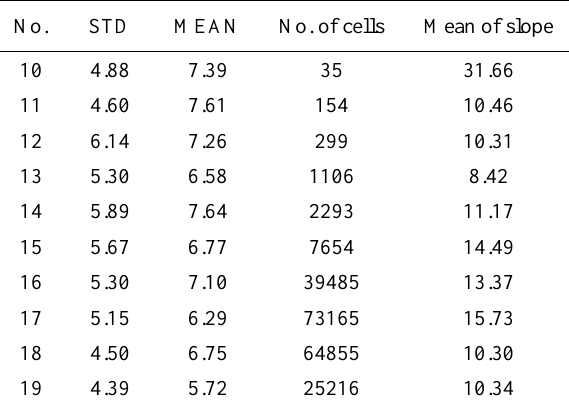
Table 2. The calculated parameters for Tazehabad study